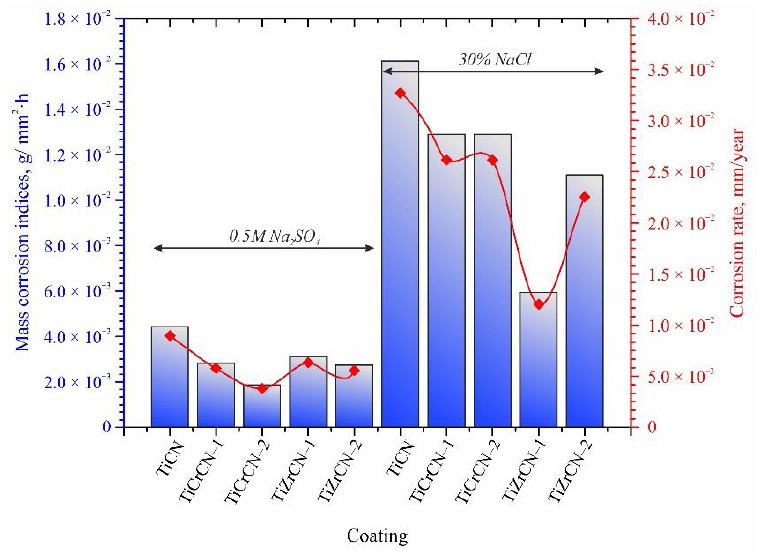
Figure 9. Corrosion indices of TiCN, TiCrCN, and TiZrCN coatings on a substrate of titanium VT1- 0.